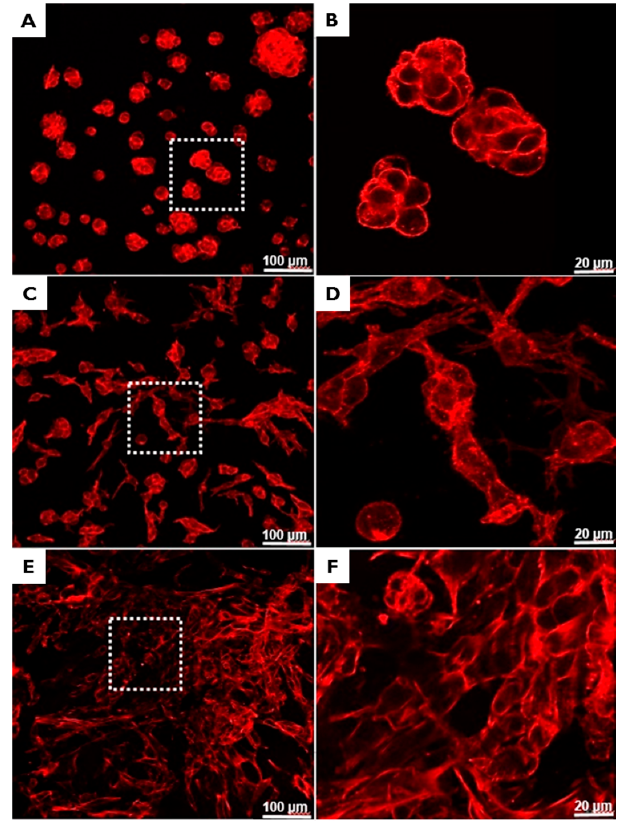
Figure 7. Immunofluorescent staining images obtained by confocal microscopy of adherent cells on NI-BCMs ( A , B ); 100k EI-BCMs ( C , D ); and 300k EI-BCMs ( E , F ). The adherent cells on EI-BCMs were more differentiated and possessed long, straight f-actin stress fibers whereas those on NI-BCMs were circular. Furthermore, degree of cell differentiation increased with irradiation dose.